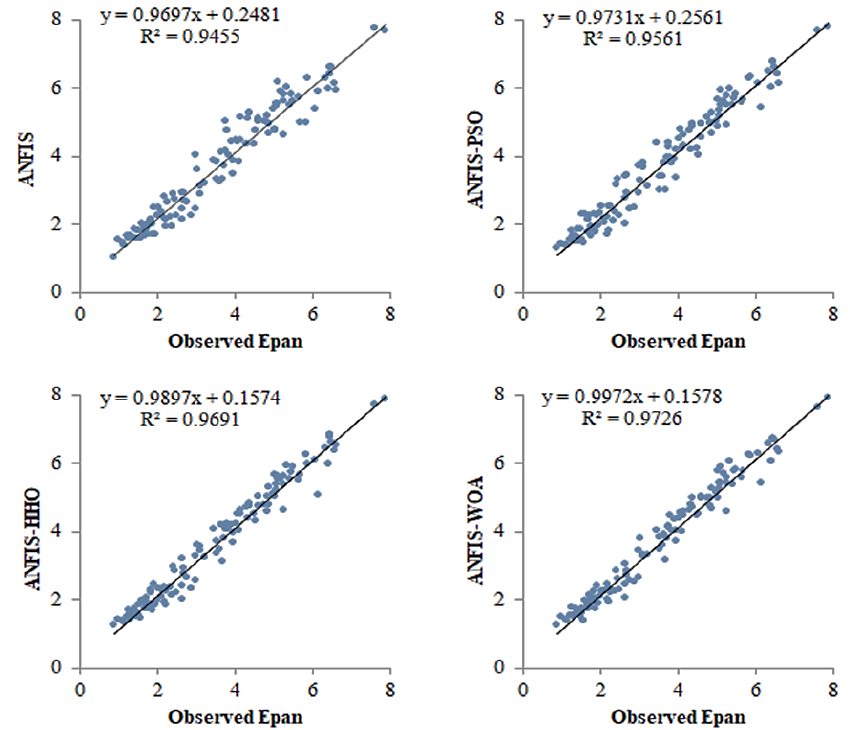
Figure 3. Scatterplots of the observed and predicted Epan using the hybridized ANFIS models in the testing phase using the best input combination—Jingzhou Station.